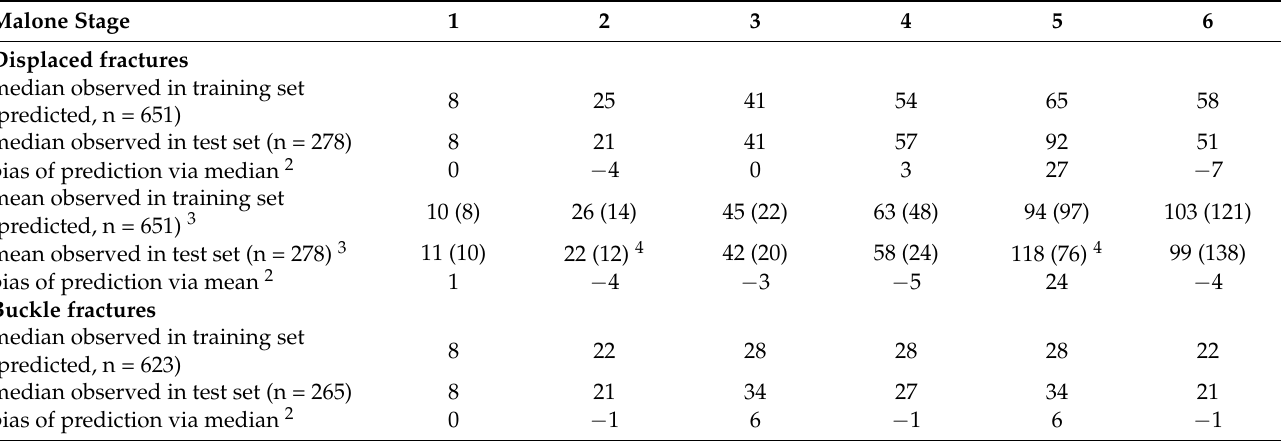
Table 3. Observed and predicted 1 median and mean age of fractures, as estimated by the Malone et al. [23] approach, days.